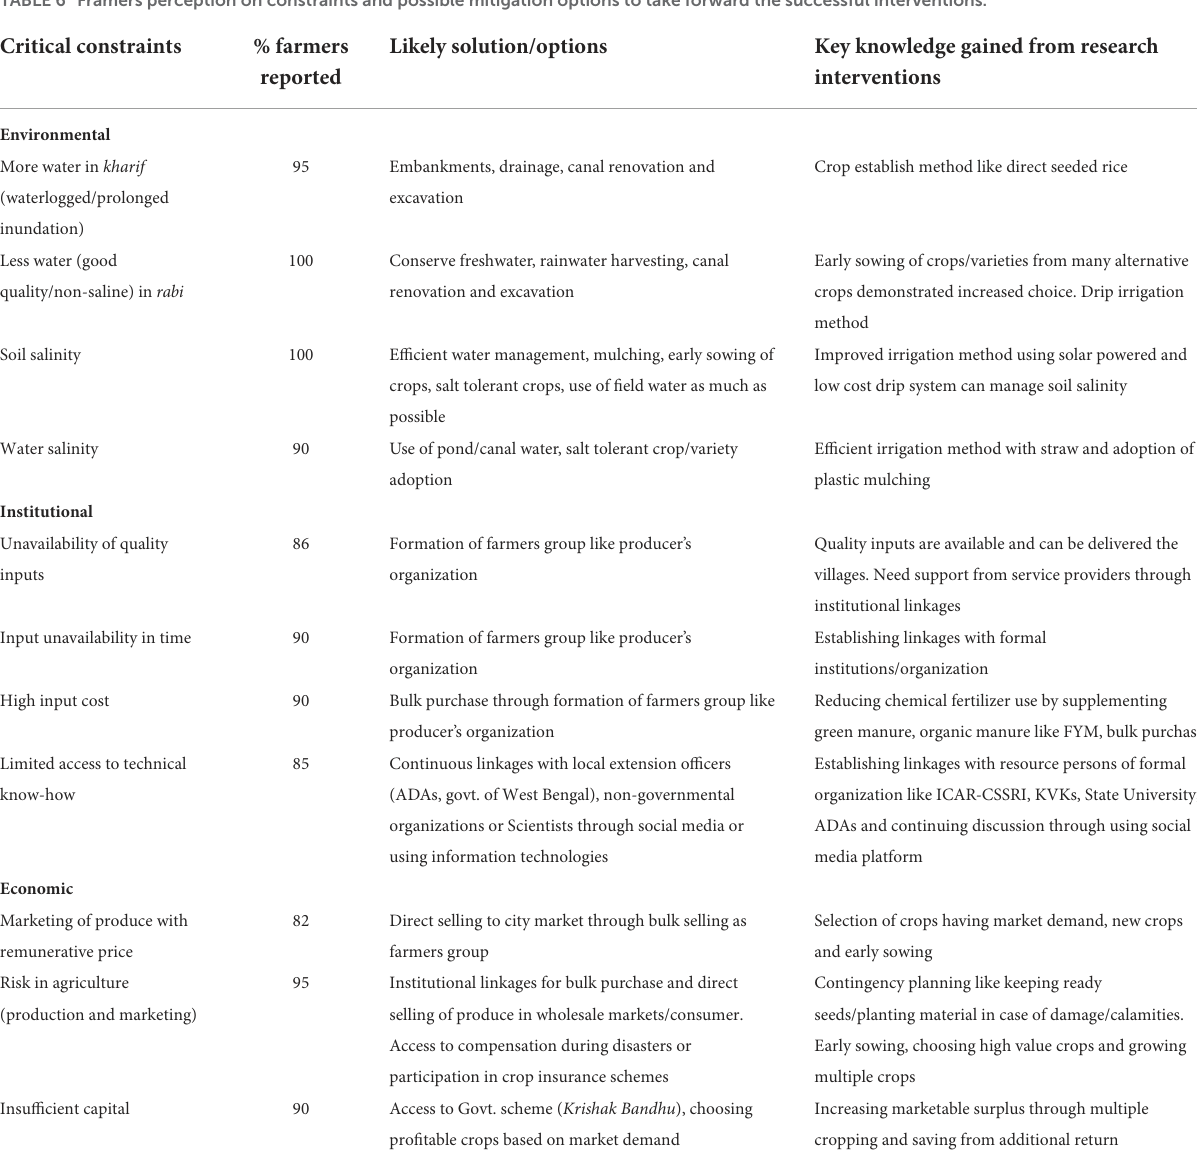
TABLE 6 Framers perception on constraints and possible mitigation options to take forward the successful